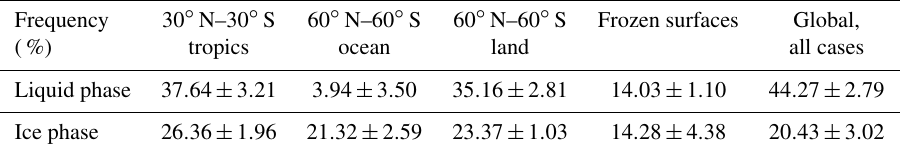
Table 3. The mean value and uncertainty range of the occurrence frequencies of ice- and liquid-phase clouds based on the variables of the cloud thermodynamic phase from the three imager cloud retrievals: MYD06, CLDRPOP_MODIS, and CLDPROP_VIIRS. Re- sults over the five types of surfaces and regions are shown, respectively, for tropics, ocean, land, frozen surfaces, and global. For each condition, five estimates of cloud-phase frequencies are available based on two types of imager-derived cloud thermodynamic phase: Cloud_Phase_Optical_Properties determined by the optical-property retrieval (provided in both MYD06 and the two continuity products) and Cloud_Phase_Cloud_Top_Properties obtained through the CLAVR-x processing system applied in the continuity cloud algorithm (pro- vided in the CLDPROP_MODIS and CLDPROP_VIIRS cloud products). The uncertainty range is characterized by the standard deviation of the five estimates obtained in each